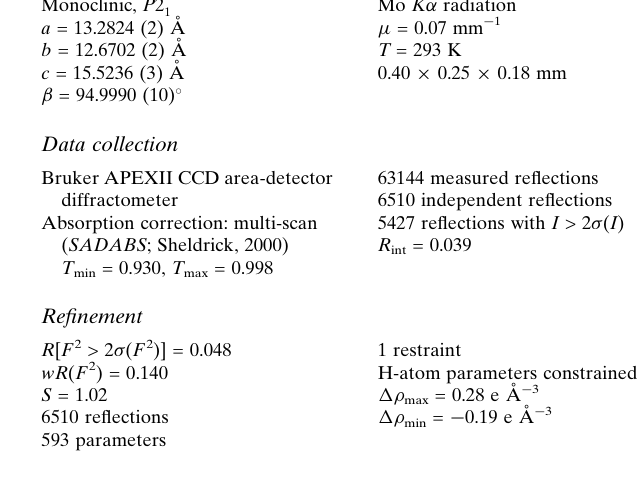
Data collection Bruker APEXII CCD area-detector diffractometer Absorption correction: multi-scan ( SADABS ; Sheldrick, 2000)